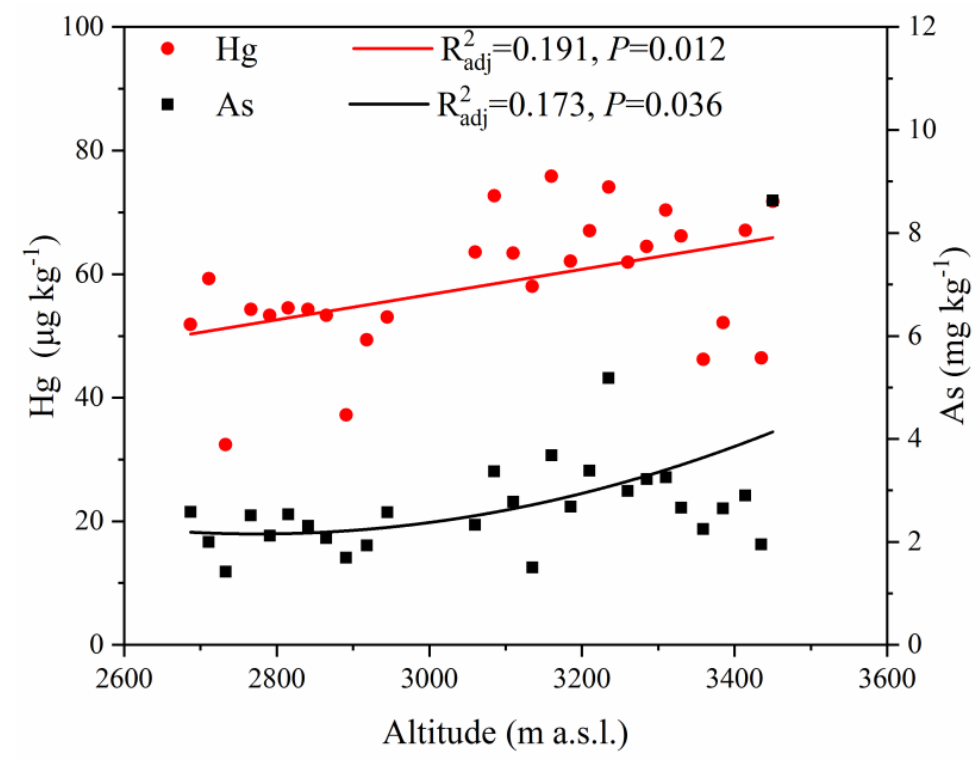
Figure 5. The altitudinal distributions of Hg and As in the moss. T he bio-concentration factor (BCF) is defined as the ratio of metal concentration in plant tissue to that in the corresponding topsoil sample, and is an important parameter for quantifying the plant uptake of Hg and As; this is displayed in Figure 6. The results show that the BCF of Hg in moss was mostly greater than 1 in the sampling sites, demon- strating that the accumulation of Hg concentrations in moss were higher than those in soil. For the different tissues of spruce, it was found that the proportions of samples hav- ing BCF values of Hg greater than 1 in bark, litterfall, and foliage were 64.3%, 32.1%, and 10.1%, respectively. However, the BCF values of Hg in shrubs and cones were <1 in all sampling sites. These results indicate that bark and moss (Table 2) and alpine shrubs are less enriched in Hg. This may be due to the high adsorption capacity of bark and moss for Hg [46,47]. The altitude was significantly negatively correlated with the BCF of moss, fo- liage, and bark ( p < 0.05) (Table S4), which indicates that the bio-concentration of Hg de- creased with increasing altitude. The negative correlations between BCF of Hg in plants and altitude might be related to the increase in atmospheric Hg 0 [14]. Except for the moss at sampling points S01 and S10, the BCF values of As in plant tissues at most of the sam- pling points were <1, indicating that the As concentrations in plants were below those in soil. The high BCF of As in S01 moss was related to the maximum As accumulation in moss (8.64 mg kg − 1 ), whereas it could be attributed to a lower topsoil As concentration (2.87 mg kg − 1 ) in S10. The average BCF of As in moss was higher than that in other plants and tissues, which may be related to the fact that moss has a greater ability to enrich metal(loid)s from atmospheric particulates [19,50]. The altitude was significantly nega- tively correlated with the BCF of foliage and bark ( p < 0.05), but was significantly posi- tively correlated with the BCF of cones and Caragana jubata (Table S4).